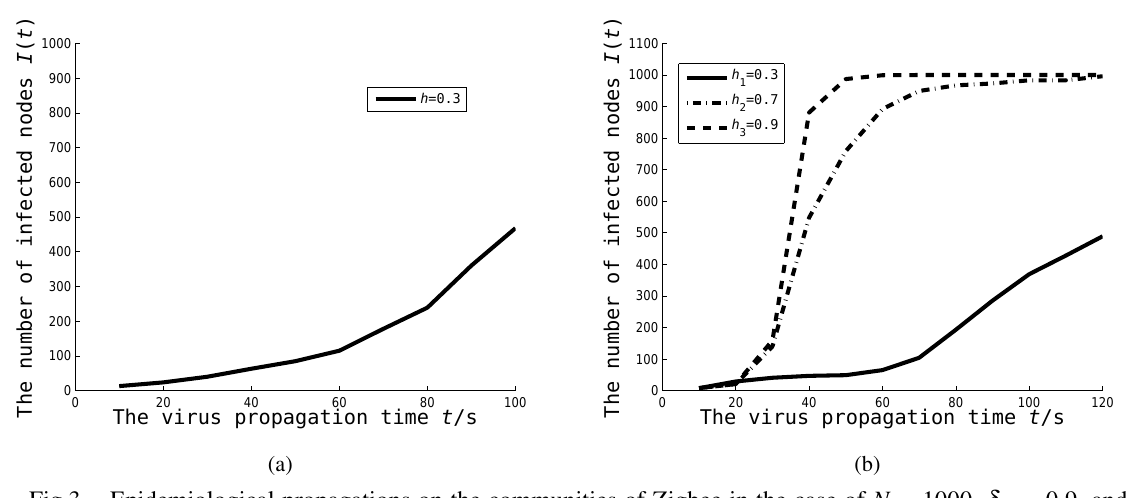
Fig.3. Epidemiological propagations on the communities of Zigbee in the case of N = 1000, δ in = 0 . 9, and δ out = 0 . 3. Here the lines represent the time evolution of the infected number on communities with (a) h = 0 . 3, (b) h 1 = 0 . 3, h 2 = 0 . 7 and h 3 = 0 .